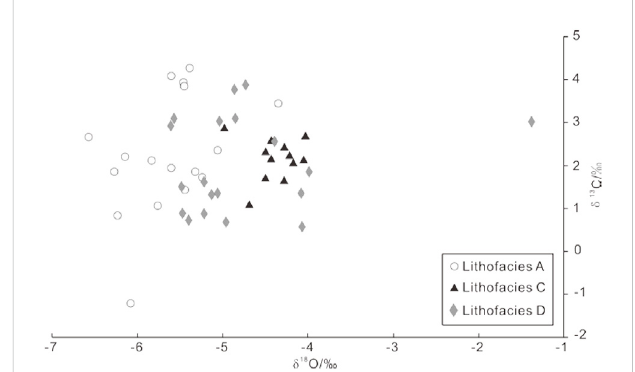
FIGURE 8 δ 13 C vs. δ 18 O of different lithofacies in Feixianguan Formation tight oolitic